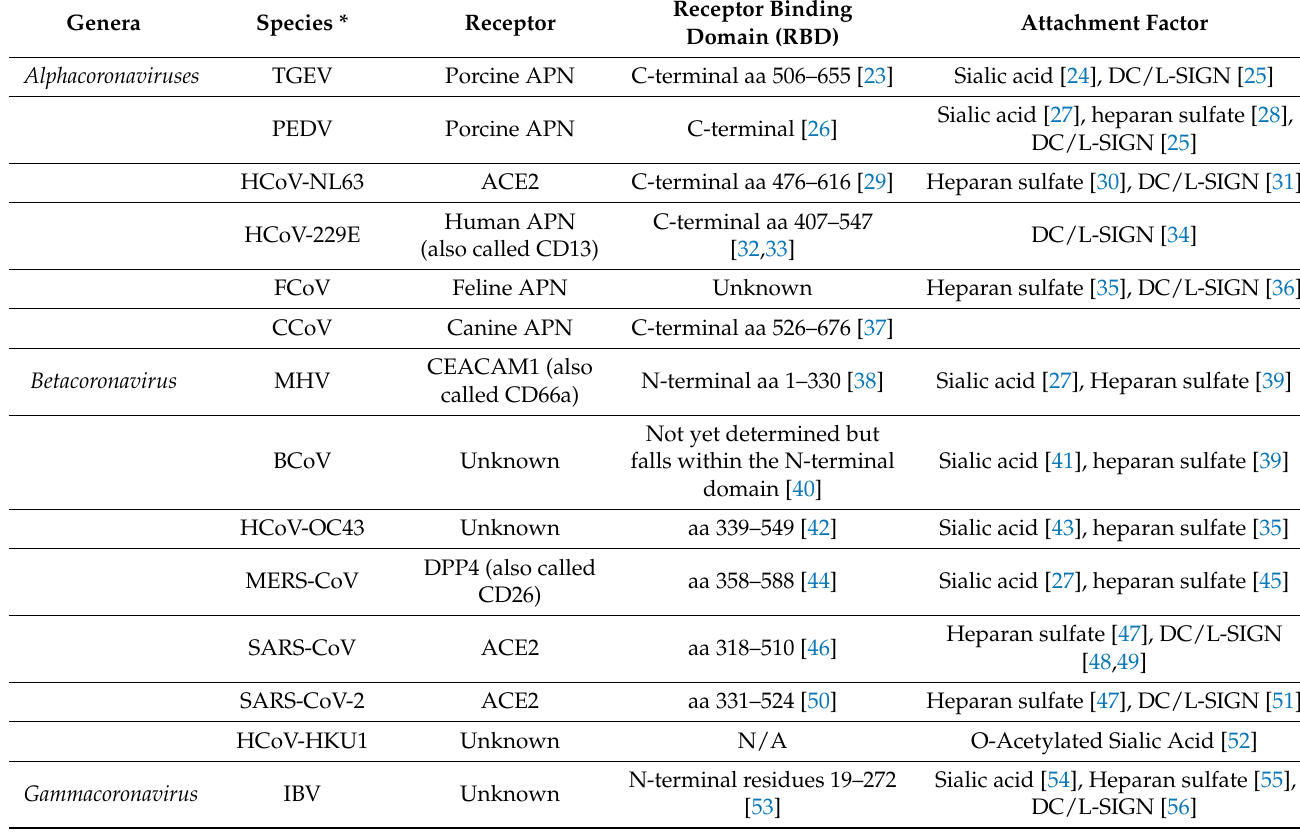
Table 1. Host receptor usage, receptor binding domains, and attachment factors for CoVs.